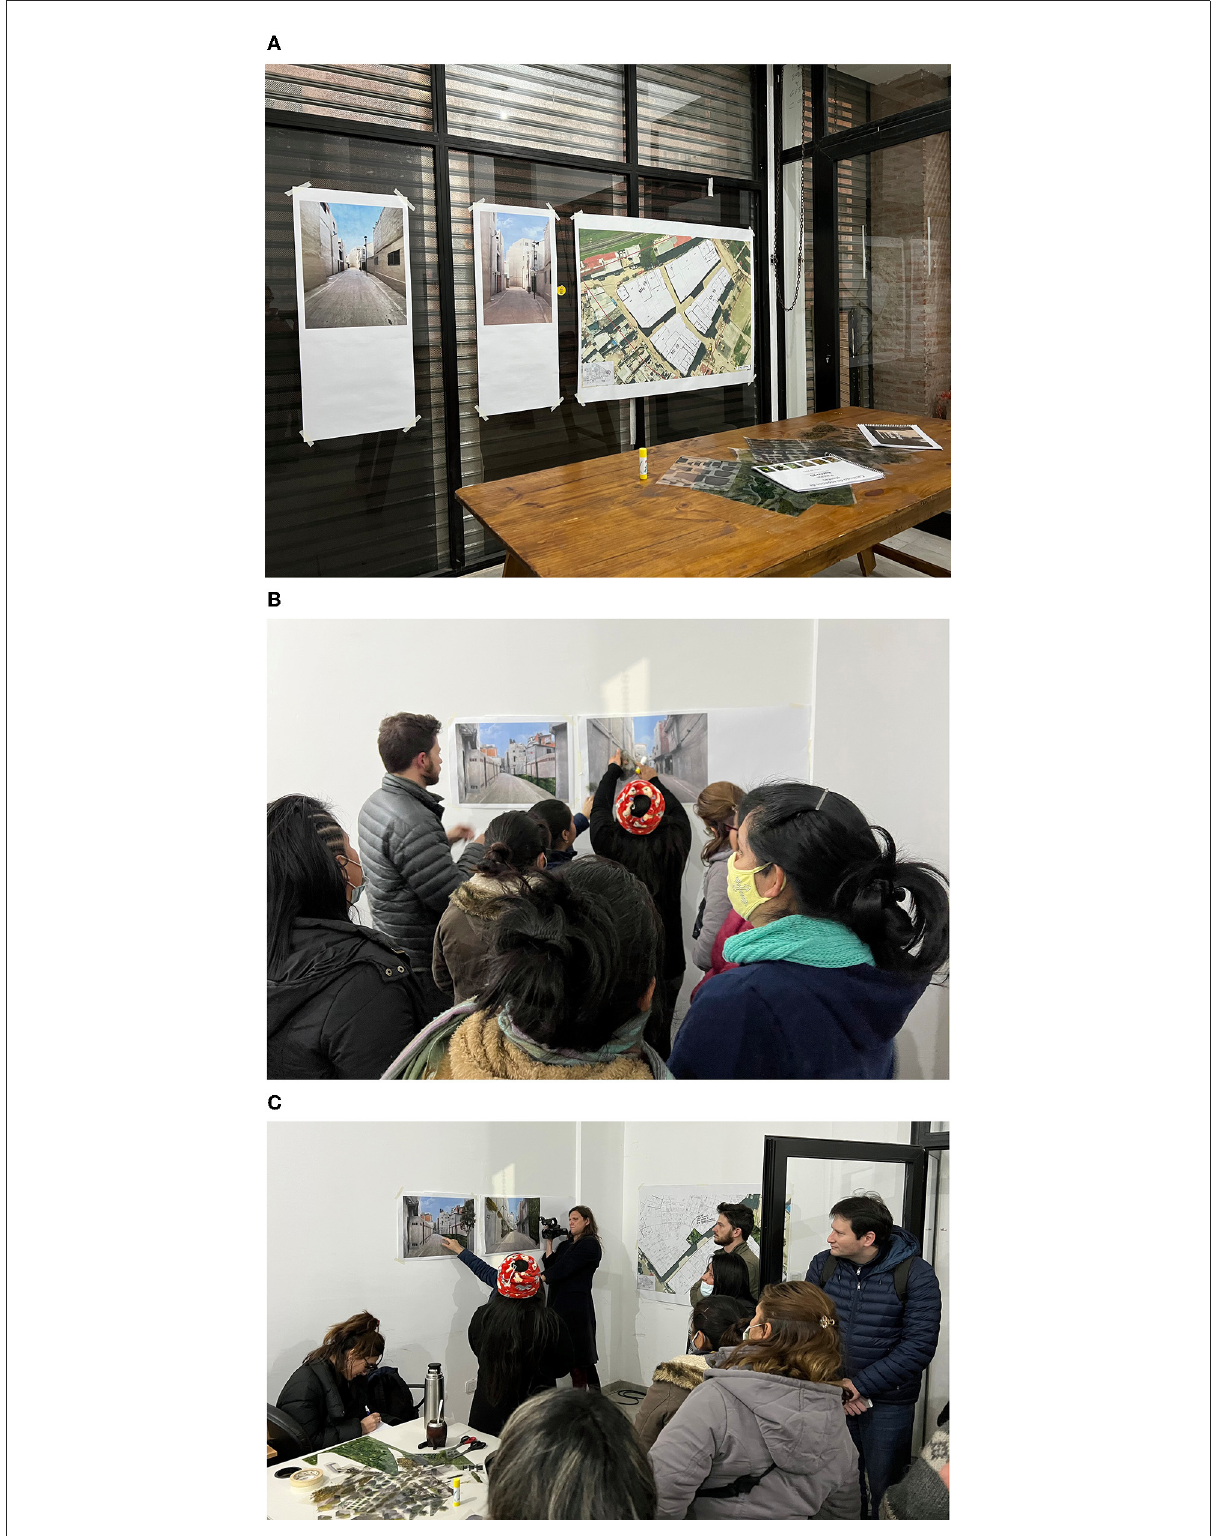
FIGURE8 (A–C) Working during Urban Lab meeting, June 2022. Source: TUC team.